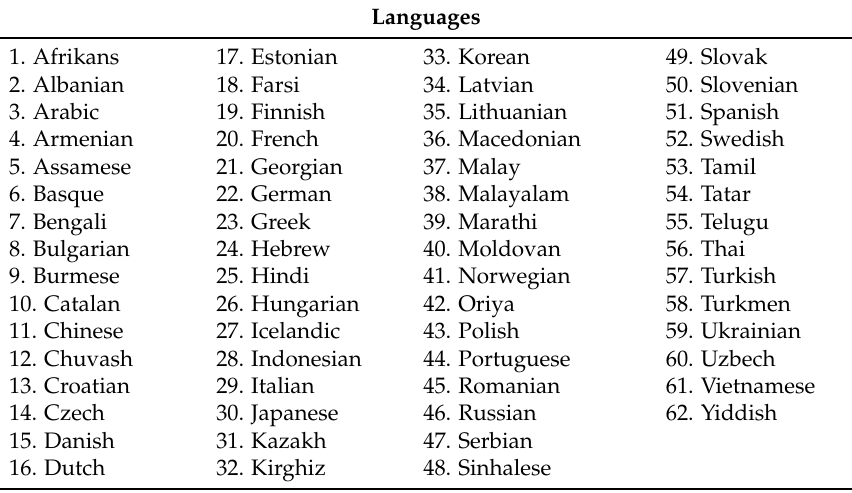
Table 1. List of languages Adventures of Huckleberry Finn was translated